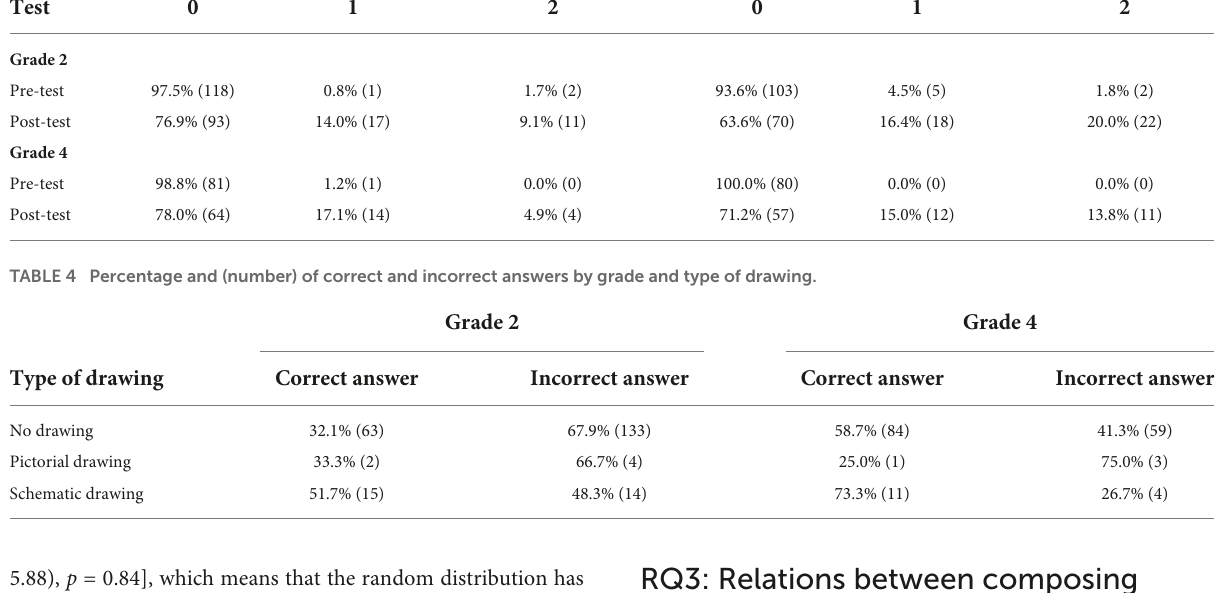
TABLE 3 Percentage and (number) of schematic drawings in intervention and control groups in pre- and post-tests. Control group Intervention group Number of tasks with schematic drawing Number of tasks with schematic drawing